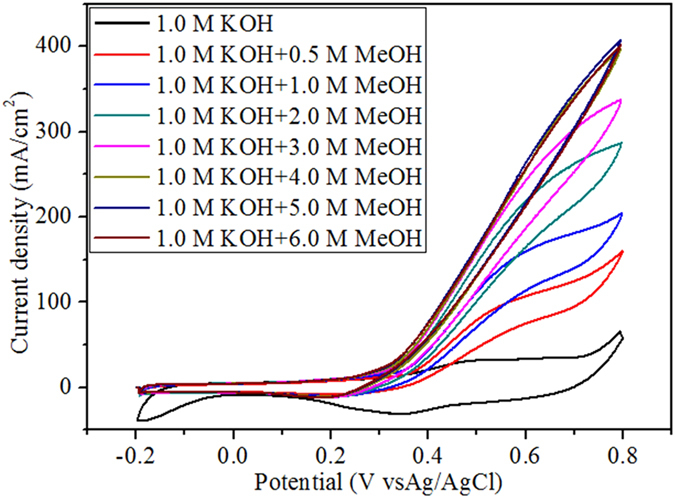
Electrocatalytic oxidation of methanol in 1.0 M KOH by NiCo2O4/MWCNT at 50 mV/s.